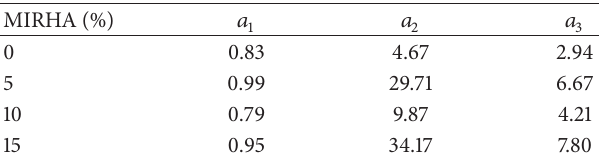
Figure 5: Degree of hydration of FC from 𝑤 𝑛 measured by OD/FI. Table 8: 𝑎 1 , 𝑎 2 , and 𝑎 3 are fitting parameters for degree of hydration of FC.